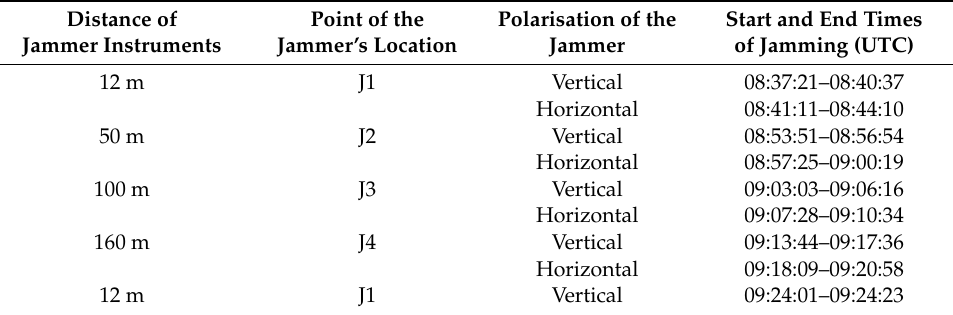
Table 3. Static positions of the jammers and times of the 3-minute jammings.